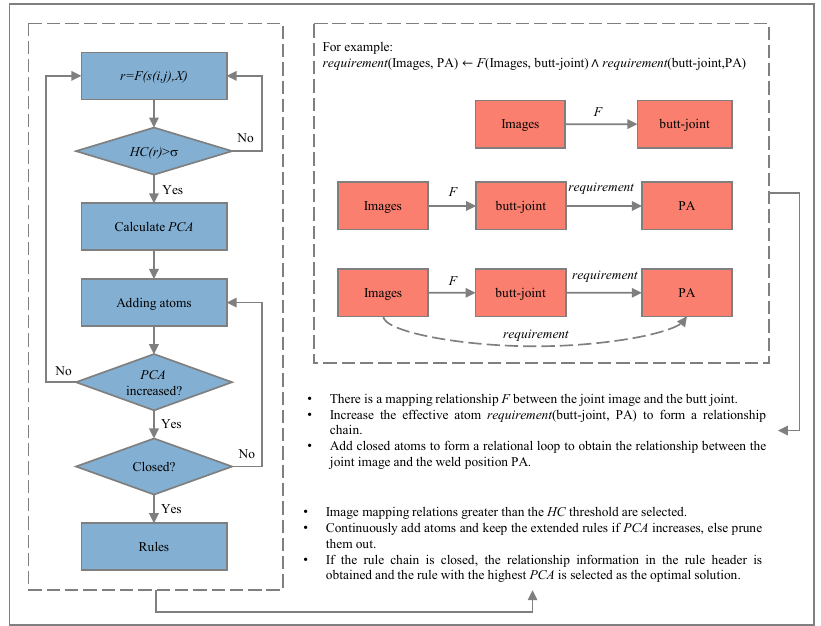
Figure 2. Inference process and example. The left side shows the depth inference process of image knowledge, while the right side shows the inference example.